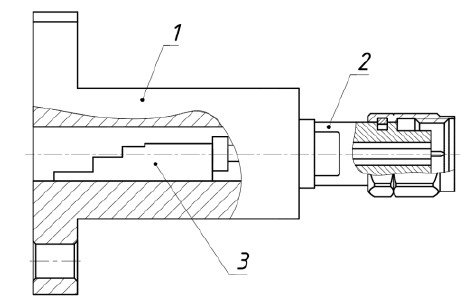
Fig. 3. Straight WCA design: 1 – Waveguide part of WCA, 2 – Coaxial part of WCA, 3 – Matching